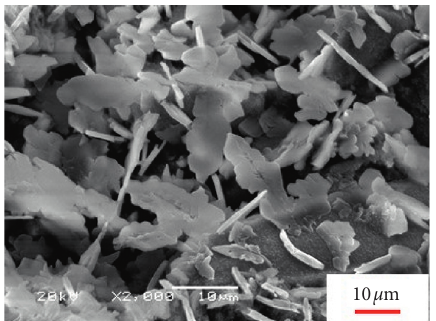
Figure 8: SEM micrograph of A8S2-5M at 7 d curing